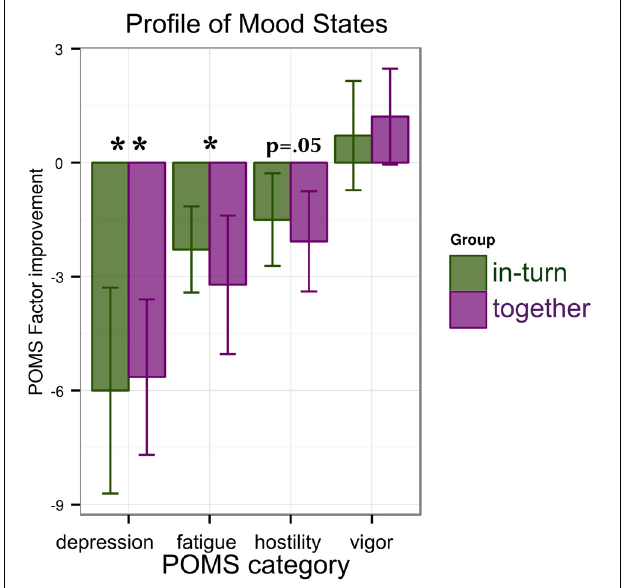
FIGURE 4 | Results of the mood tests: patients show reductions in depression/anxiety and fatigue that are similar between groups. A trend for improvement (decrease) in hostility is observed. Significance is indicated as follows: ∗ p < 0 . 05, ∗∗ p < 0 . 01.